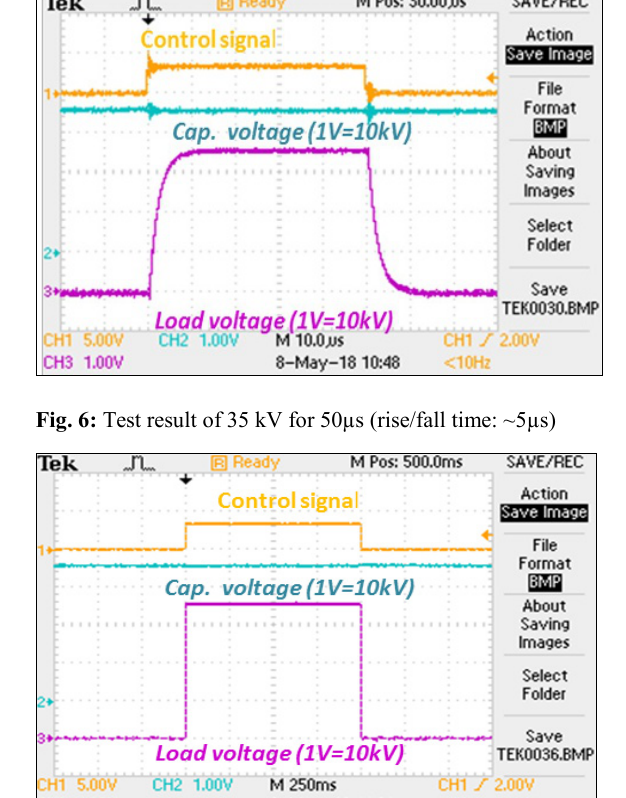
Fig. 7: Test result of 35 kV for 1 s